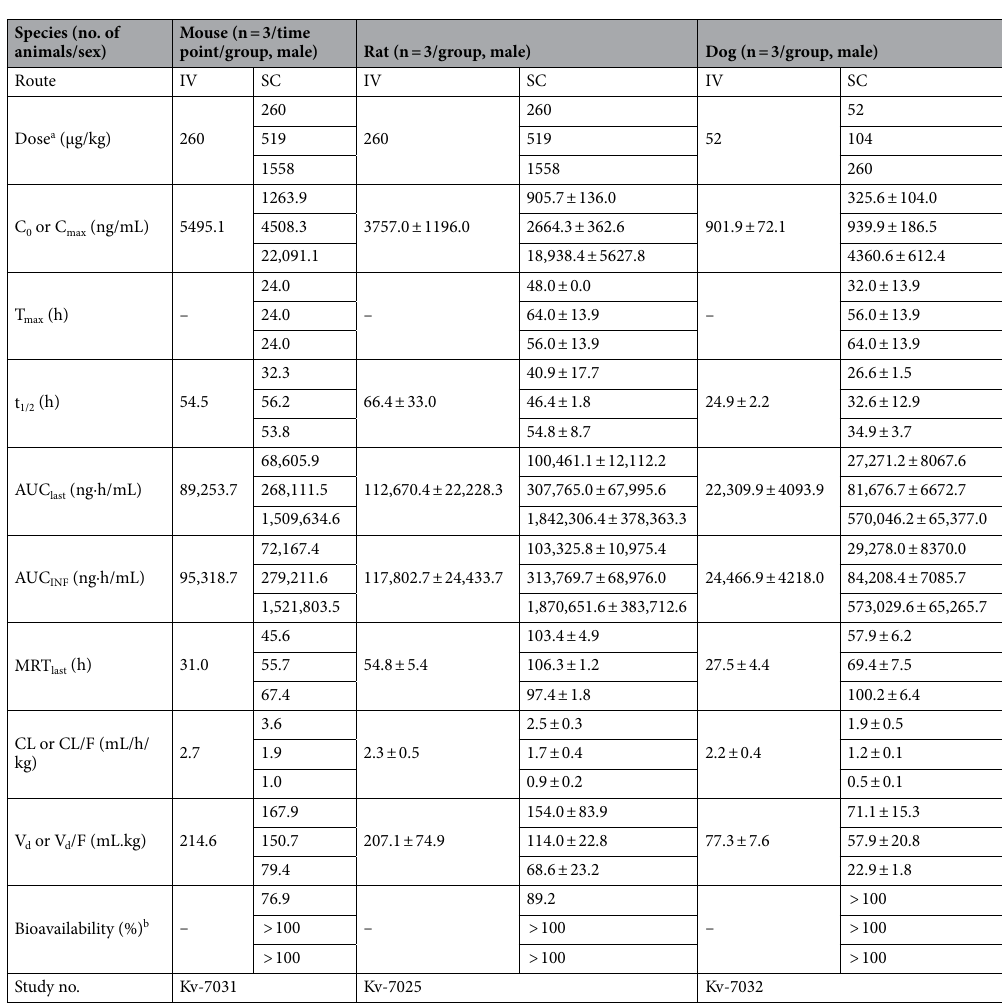
Table 1. Summary of HM15136 PK parameters in animals. IV intravenous, M male, SC subcutaneous, CL clearance, F bioavailability. a Vehicle: 20 mM Na-citrate (pH 5.0), 0.1 mg/mL l-methionine, 8% sucrose, 0.02% polysorbate 20. b Bioavailability was calculated based on AUC last